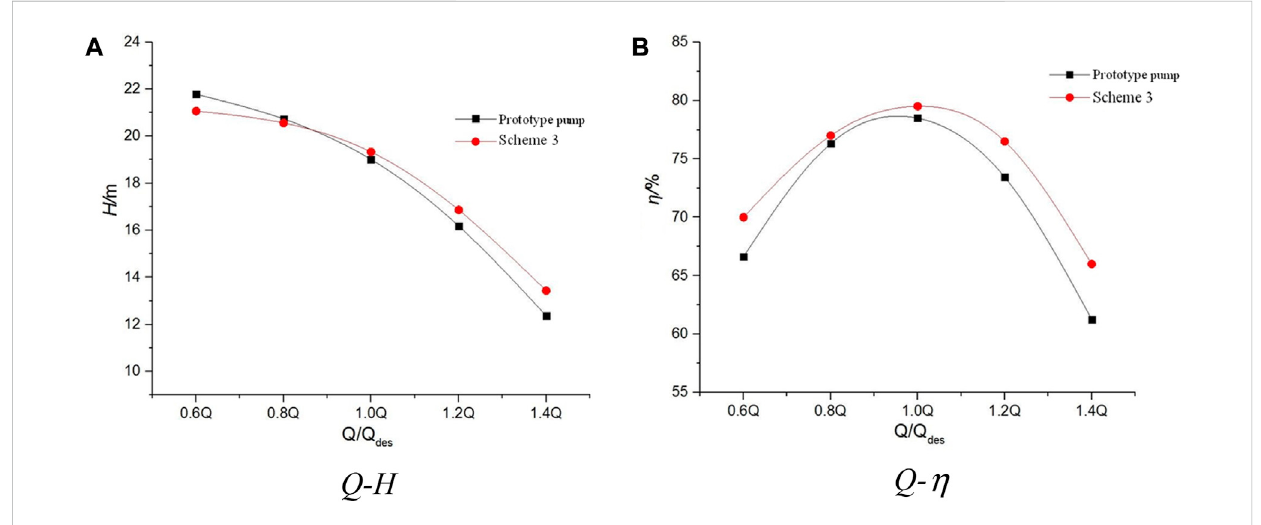
FIGURE 14 The performance curves of Scheme 3. (A) Q-H ; (B) Q- η .